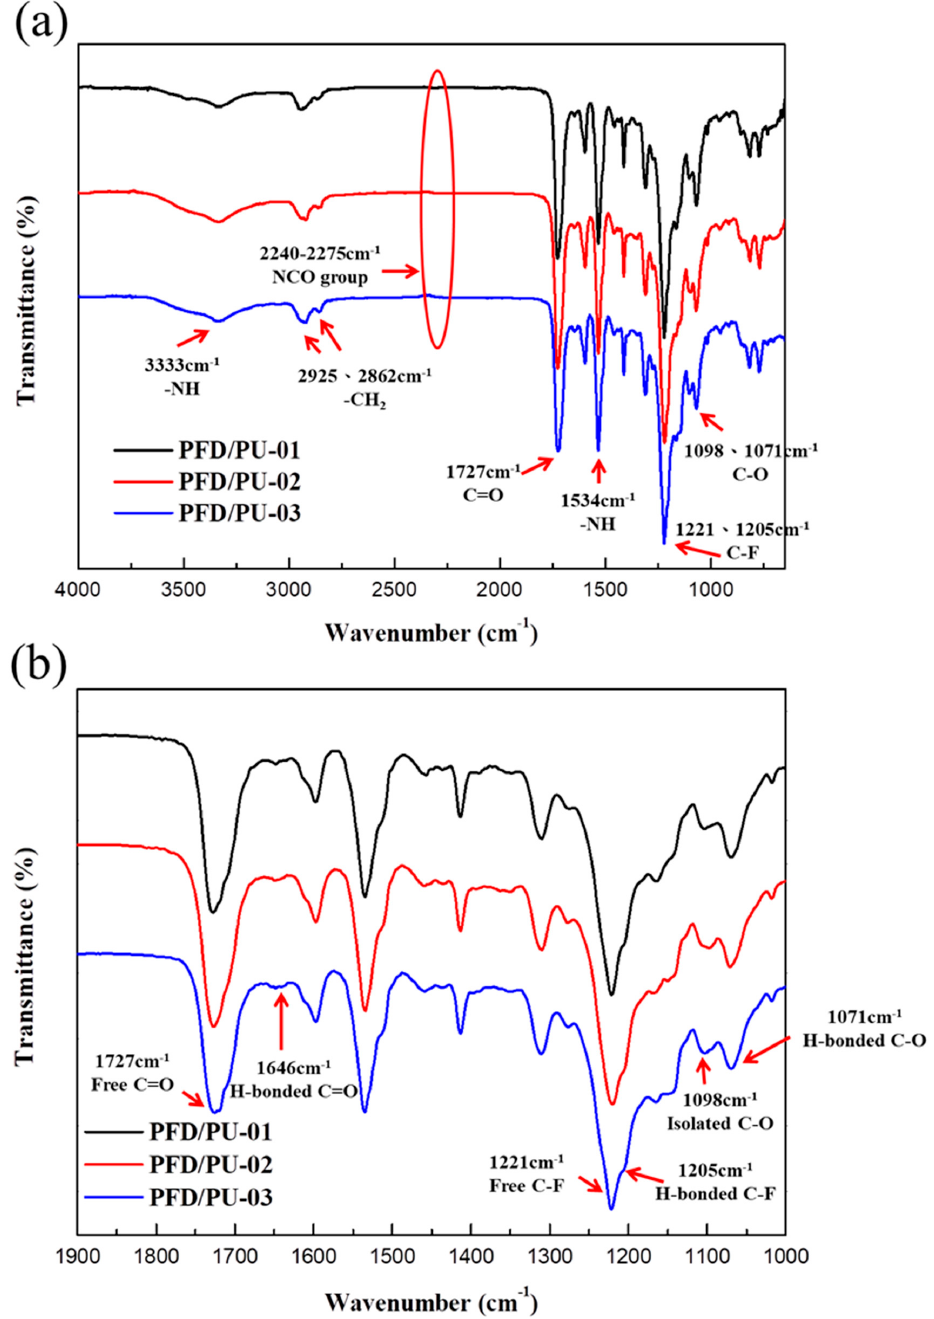
Figure 2. FT-IR spectra of PFD/PUs at wavenumber range of ( a ) 4000–650 cm − 1 and ( b ) 1900–1000 cm − 1 . Figure 2b shows the absorption peak within the wavenumber range of 1900–1000 cm − 1 . FTIR analysis conducted by Yang et al. [27] showed that C=O functional groups obtained from the PU system using the curve-fitting technique included C=O free , C=O HB disordered , and C=O HB ordered , with C=O HB ordered appearing at approximately 1724, 1701, and 1660 cm − 1 . Wang et al. [28] subjected FPU to an FTIR test, and the data indicated that when the C=O and –NH functional groups appeared at three peaks (free, disordered, and ordered) in the curve fitting, C–O and C–F functional groups produced two peak values (free and HB). The HB percentage of FPU was calculated at 1530 cm − 1 because the stretching vibration